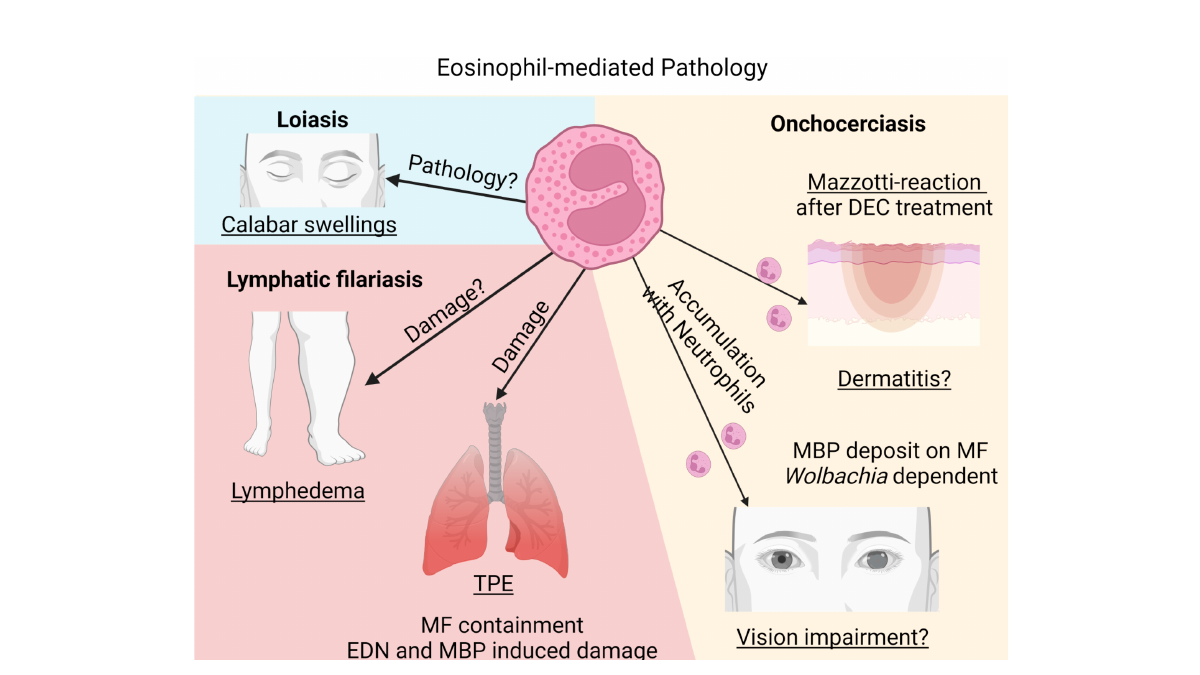
FIGURE 3 Eosinophil-mediated pathology during fi larial infections. Created with